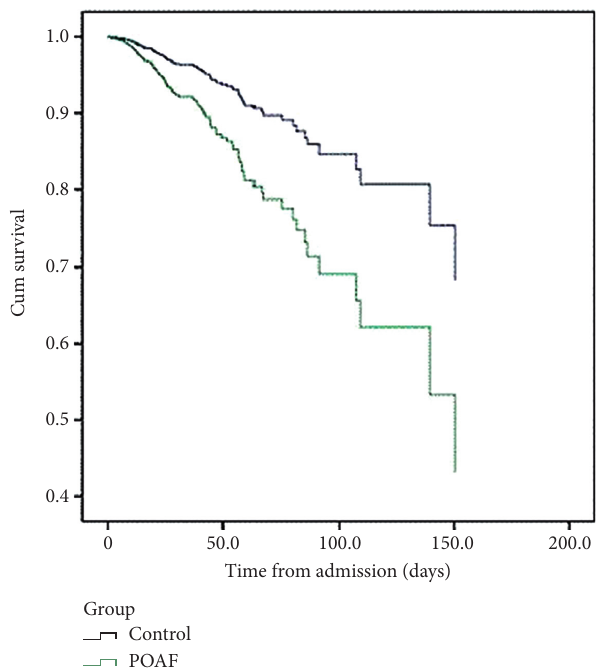
Figure 2: Kaplan–Mayer survival curve among study groups.